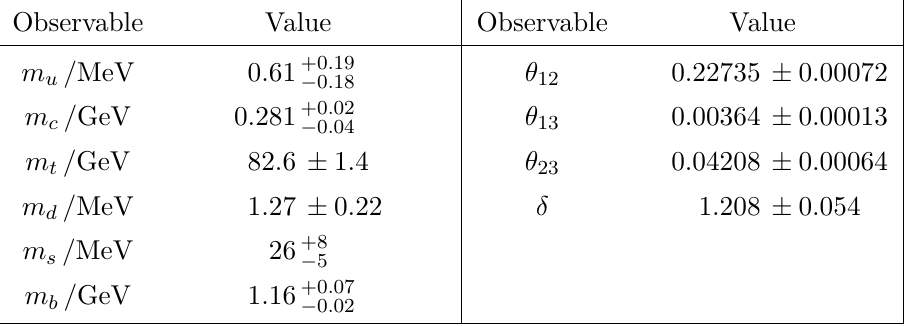
Table 1 . Input values of the quark masses and CKM parameters taken from [40, 41] (see text). Note that in general U , written in terms of V d and V , will not turn out to be real; a 12 CKM L real value, in agreement with the matrix in eq. (3.1), can be obtained by shifting the phase in M as (cid:11) ! (cid:11) (cid:0) arg U . Finally, the RH mixing matrices V d;u 12 d